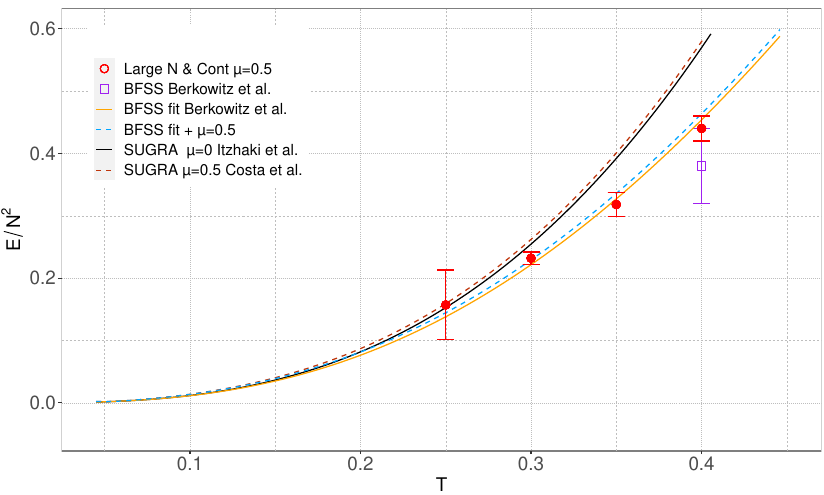
Figure 2 . Zoomed-in view of the low-temperature region. The dashed lines include finite µ corrections. The blue and orange lines are based on the ansatz (3.28) including α 0 -corrections from